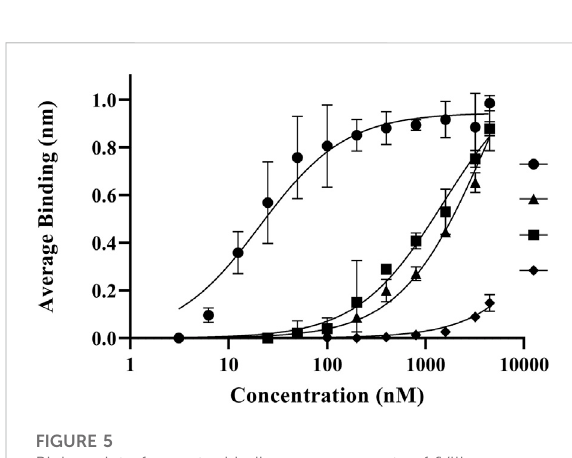
FIGURE 5 Biolayer interferometry binding measurements of fVIII C1C2 domain mutations to lipid nanodiscs. Average association binding for bound C1C2 wildtype (closed circle), R2163S (closed triangle), R2320S (closed square), and R2163S/R2320S (closeddiamond)withlipidnanodiscs(80%PC/20%PS).Abaseline was established from 100% DOPC